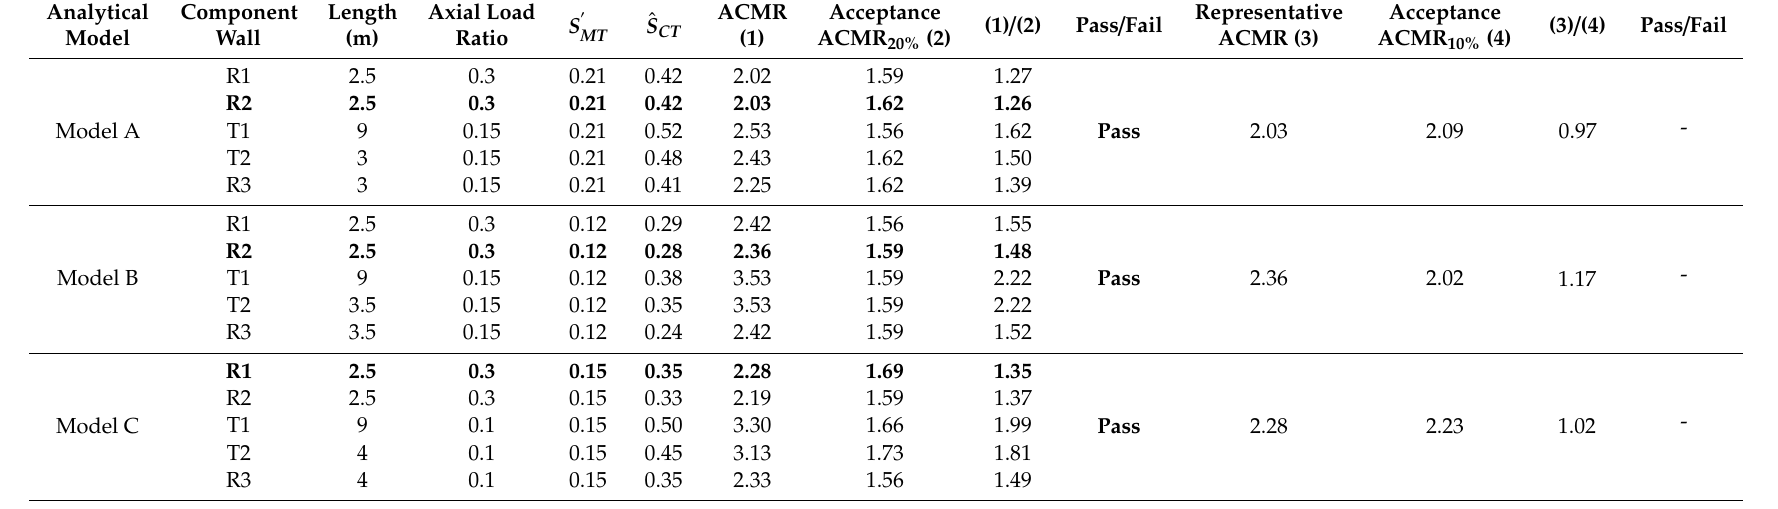
Table 11. Summary of collapse performance evaluation for analytical models designed for the shear force amplification factor =